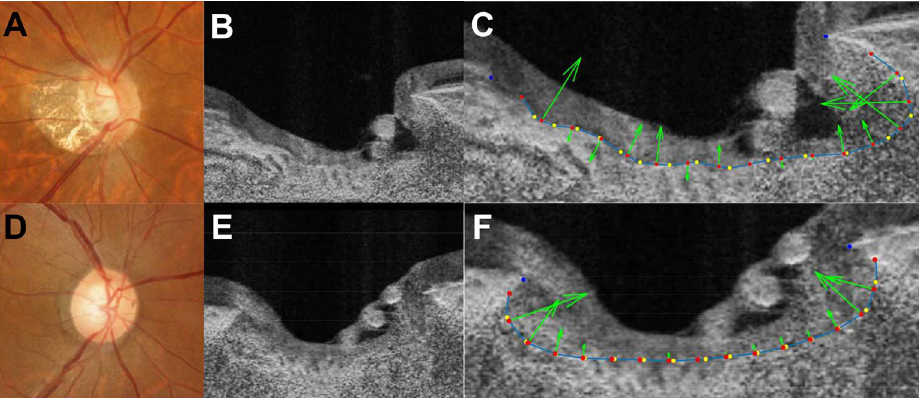
Figure 2. Representative cases with visible nasal LC. Representative images of myopic eyes ( A–C ) and non- myopic eyes ( D–F ) are presented. The images of myopic eye are from a 51-year-old female with refraction of − 7.0 D and an axial length of 26.1 mm. The images of non-myopic eye are from a 66-year-old female with refraction of + 2.6 D and an axial length of 23.9 mm. The first column ( A,D ) shows disc photographs. The second column ( B,E ) provides horizontal SS-OCT optic disc B-scans. The third column ( C,F ) provides the calculated vectors of LC curvature (green arrows), as measured from each equally-divided dot (red dots). The nasal LC curvature was 1.80 (1/mm) and the temporal LC curvature was 0.78 (1/mm) for the myopic eye and 1.56 (1/mm) and 1.75 (1/mm), respectively for the non-myopic eye.